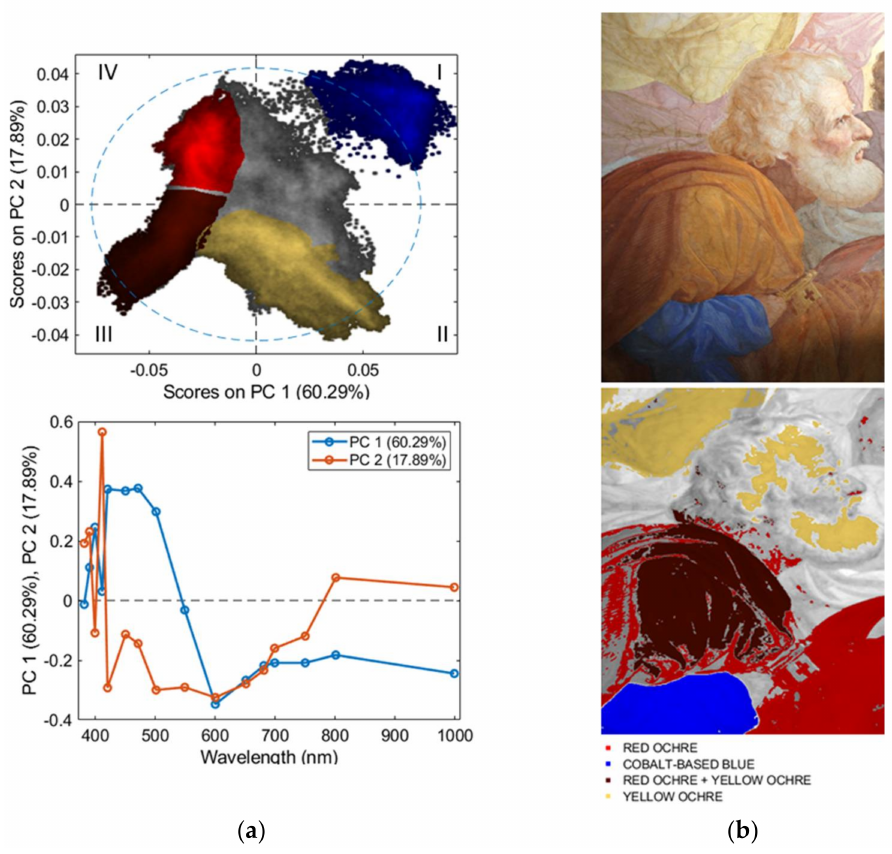
Figure 7. PCA score and loading plot of PC1 and PC2 ( a ) and relative false color image of AREA 1 ( b ). AREA 3: The PCA model requires six PCs to express a total captured variance of 94.98% (Figure 8). In detail, the PC1–PC3 score plot (Figure 8a) shows a cluster separation between the “cobalt-based blue”, “green chrome”, “yellow ochre”, and “cobalt-based blue + ultramarine” classes. Pixels belonging to the “yellow ochre” class mainly occur in the first and second quadrants (positive values of PC1). The spectra of ‘’green chrome” can be identified by the negative value of PC3 in the second and third quadrants. The spectra belonging to “cobalt-based blue” classes occur mainly in the fourth quadrant, whereas, the “cobalt-based blue + ultramarine” class is in the third quadrant. The loading plots of PC1 and PC3 show how the variance detected in the PCA score plot mainly depends on the spectral region from 400 to 800 nm (Figure 8a). Figure 8b shows the multispectral image highlighting the classes clustered in the corresponding PCA score plots. In detail, the